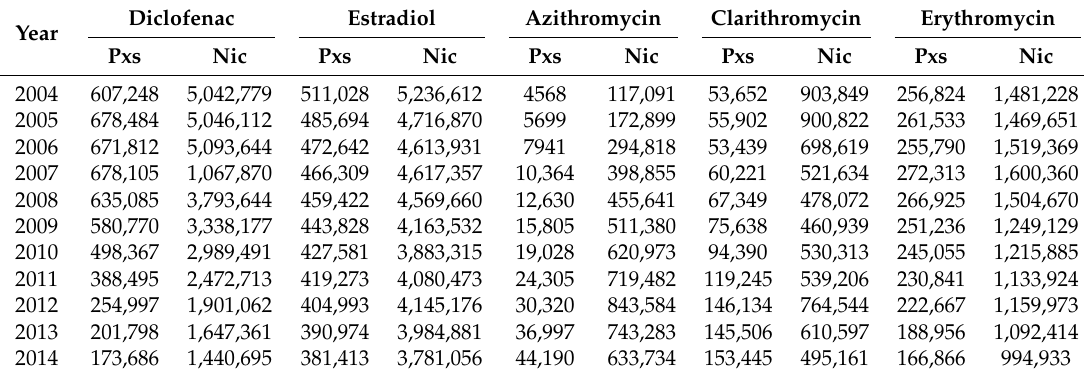
Table B2. Total Prescriptions Items and Total Cost per each Examined Substance from 2004 to 2014 in